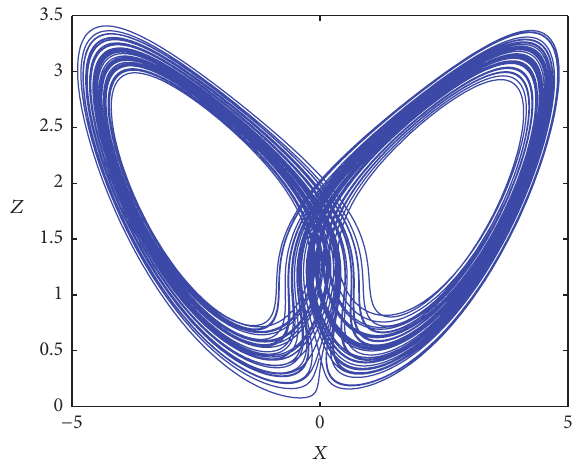
Figure 10: Lorenz-like chaotic attractor in the proposed system {𝑎 = 20 and 𝑑 = 10} .